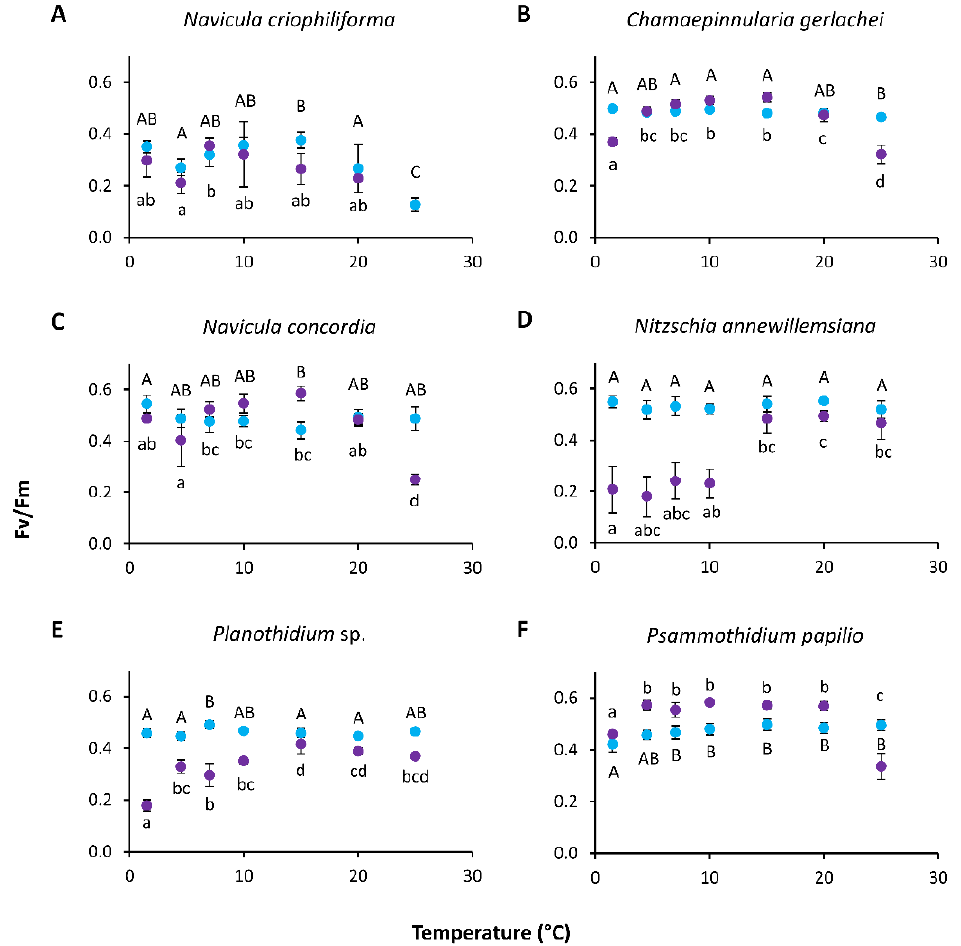
Figure 7. Effective quantum yield of photosystem II (Fv/Fm) as a function of temperature of six benthic diatom strains from Antarctica after 0 days (blue) and 5 days (purple) of incubation ( A – F ). Data represent mean values ± SD ( n = 6). Different capital (t 0 ) and lowercase (t 5 ) letters indicate significant means ( p < 0.05; one-way ANOVA with post hoc Tukey’s test). ( A ) Navicula criophiliforma , ( B ) Chamaepinnularia gerlachei , ( C ) Navicula concordia , ( D ) Nitzschia annewillemsiana , ( E ) Planothidium sp., and ( F ) Psammothidium papilio